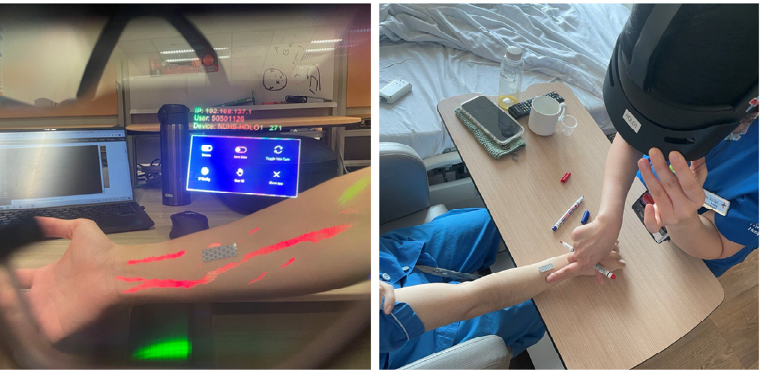
Figure 1. “First ‐ person view” using HoloVein ( left ), with vein overlay shown around the grey sticker and control panel visible. Third ‐ person view of user ( right ), with HoloLens 2 and sticker in